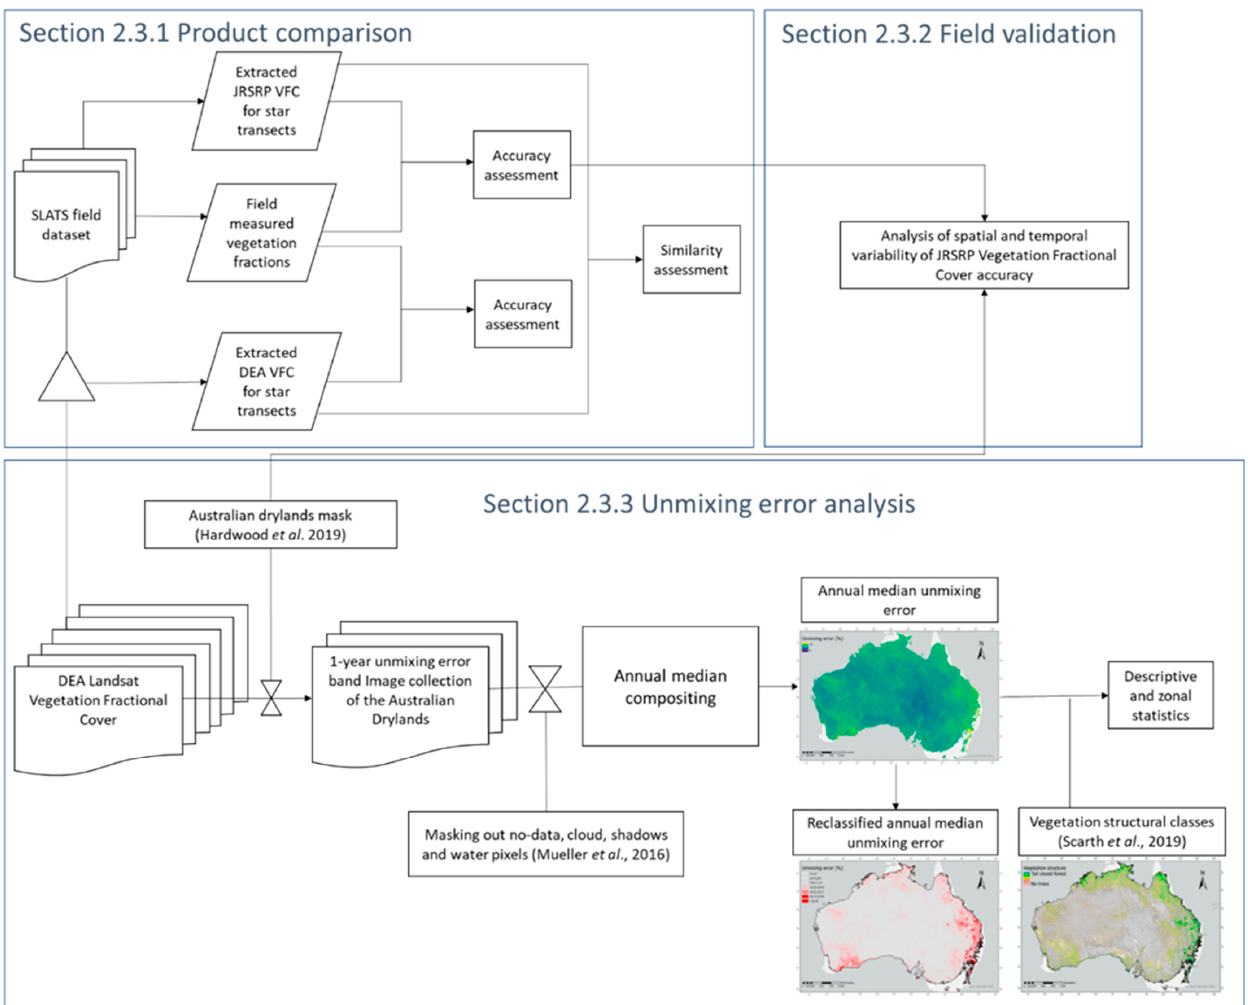
Figure 3. Flow chart depicting the processing steps and combinations of datasets. Each section addresses a separate research question.